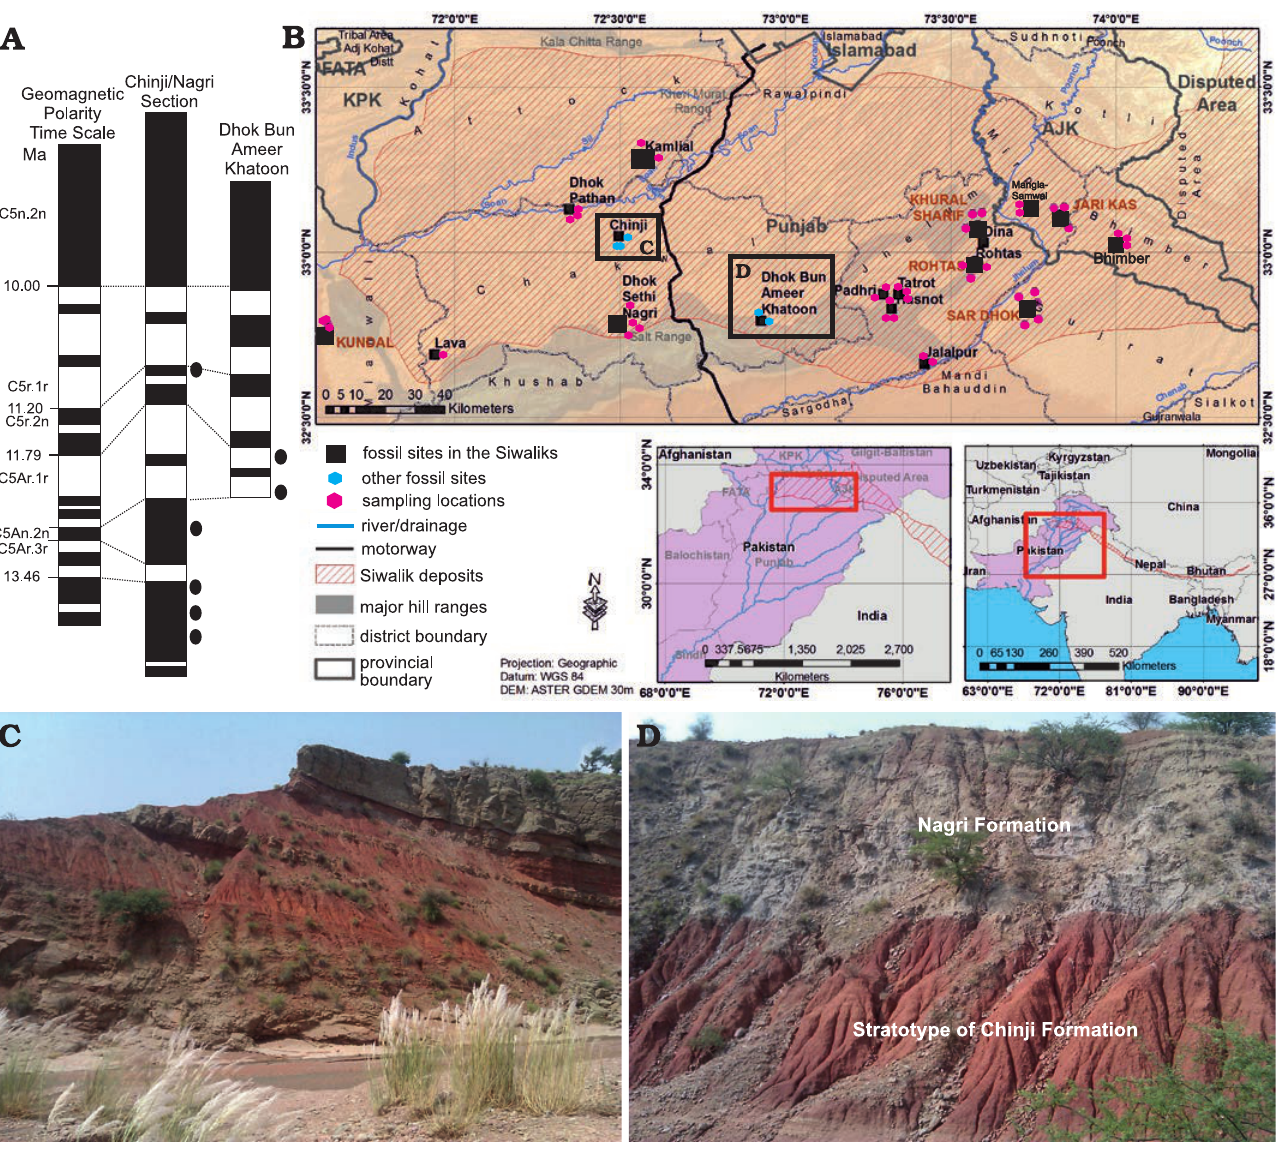
Fig. 1. Map of the Siwaliks indicating the middle Miocene localities from where fossil material for this study was recovered. A . Geomagnetic polarity time scale (Gradstein et al. 2012). B . Map of the Siwalik sub-Group of Pakistan along with the localities and studied area. C . Overview of Chinji-Nagri section. D . Overview of Dhok Bun Ameer Khatoon (DBAK)